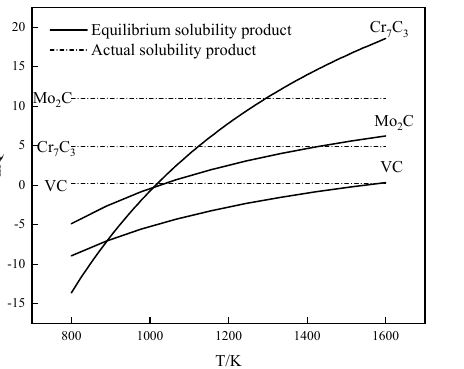
Figure 12. Curves of equilibrium solubility product and actual solubility product to temperature of solid HSS.